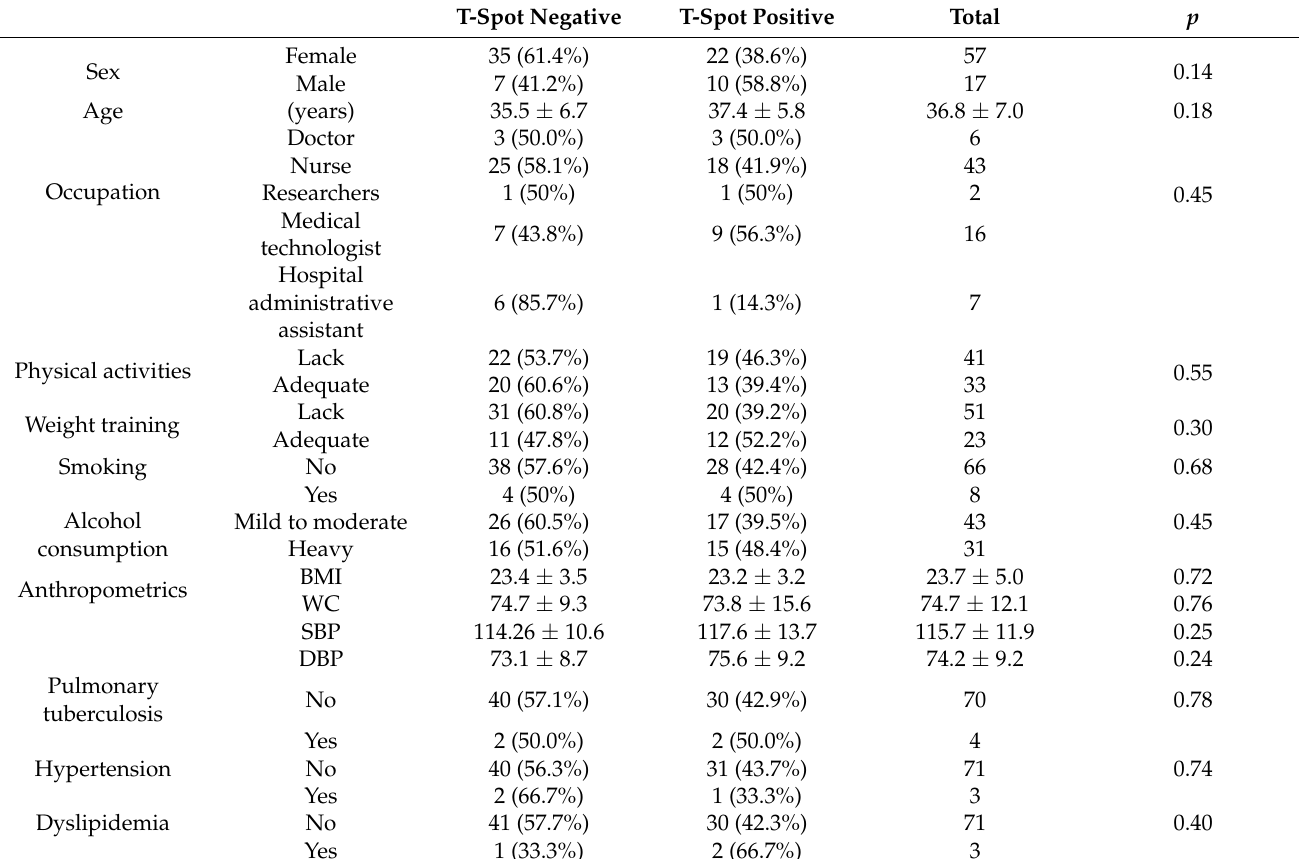
Figure 2. Distribution of T-spot assay results in 74 participants who completed second AZD1222 vaccination with its Gaussian density estimation line. In terms of cellular immunity, 32 of participants (43.2%) presented as positive in the T-spot test. The T-spot-positive group showed a higher Cr and lower eGFR (Table 2); however, in both groups the values of eGFR were in the normal range, except for one female participant. Table 2. Results of T-spot assay according to the clinical